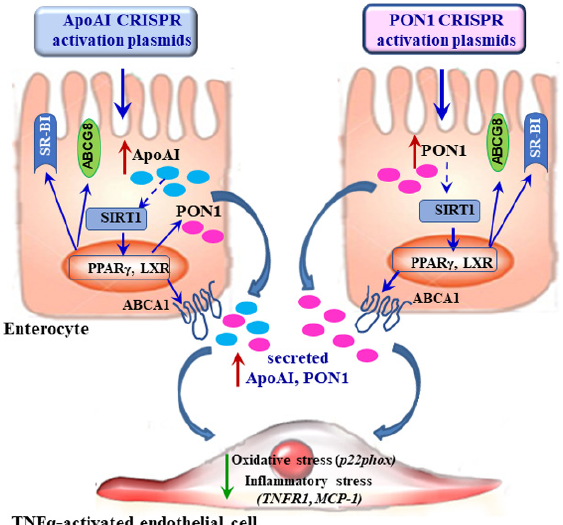
Figure 6. Schematic representation of the benefic effects induced by the transcriptional activation of the endogenous apoAI or PON1 in enterocytes. Transfection of Caco-2 cells with CRISPR/dCas9 activation plasmids for apoAI or PON1 increases their gene and protein expression, as well as their secretion in the culture medium. Overexpressed apoAI and PON1 exert a positive feedback regulation on their transcription factors PPAR γ , LXRs, and SIRT1. In turn, these transcription factors upregulate the lipid transporters ABCA1, ABCG8, and SR-BI which are known to be anti-atherogenic. The apoAI and PON1 secreted by the transfected enterocytes in the culture medium are able to attenuate the TNF α -induced inflammatory and oxidative stress in EC, by decreasing TNFR1, MCP-1, and p22phox levels.